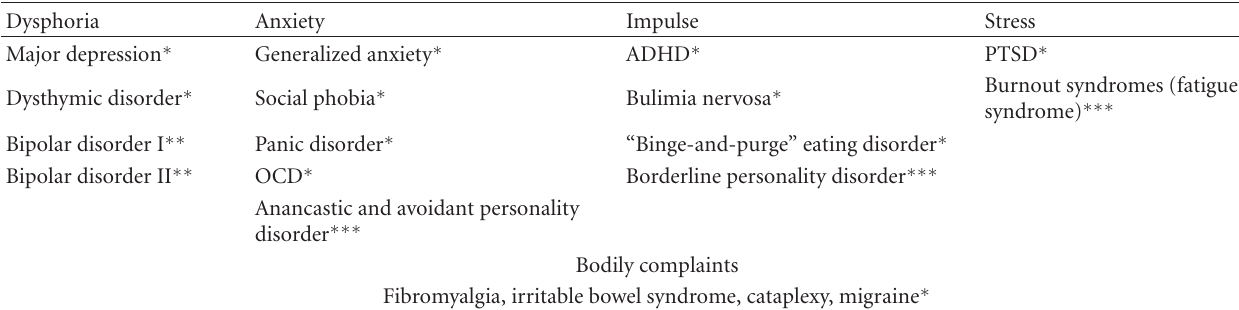
Table 1: Schematic model of A ff ective spectrum disorders (AfSDs), an interpretation and expansion of the concept as discussed in [2–6,